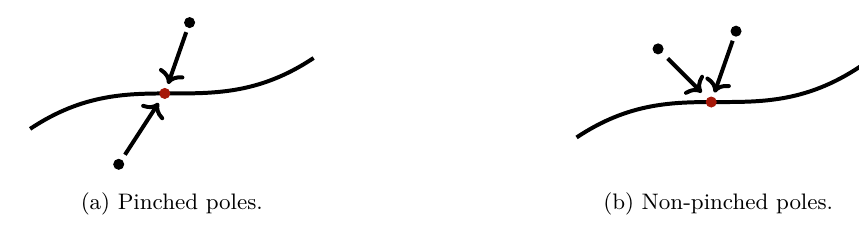
Figure 1. Two ways that poles merge onto the integration contour for (cid:15) → 0